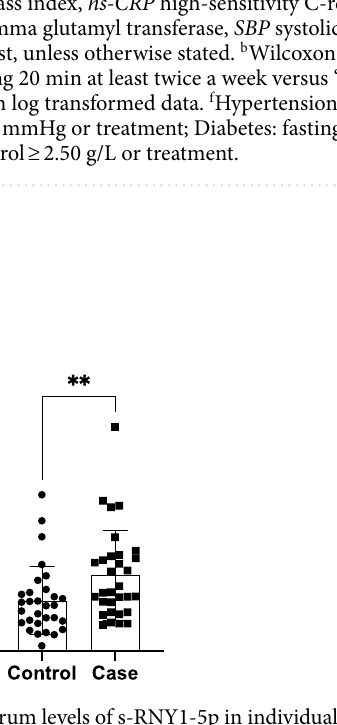
Figure 2. Serum levels of s-RNY1-5p in individuals from the nested Case–Control study when they were first included in the GENES cohort. Box plot showing the absolute expression of circulating s-RNY1-5p in Cases (n = 30) and Controls (n = 30). Absolute expression data derived from the standard curves created by synthetic s-RNY1-5p by RT-qPCR, normalized by 1 mL of serum, and presented as median and IQR. Wilcoxon signed rank sum test **p <